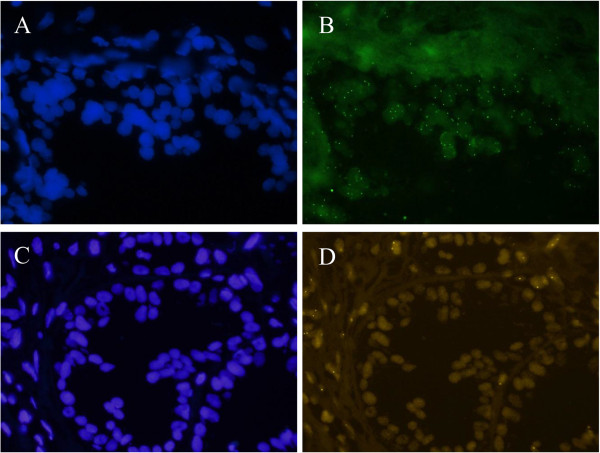
Images of abnormal FISH signals. A and B: The images of MYC SpectrumGreen copy number gain with DAPI staining (A) showing the nuclei morphology, and MYC staining (B) displaying gain of copy numbers. C and D: the images of PTEN loss with DAPI staining (C) of the tumour ROI, and PTEN FISH hybridisation showing deletion of PTEN in the prostate gland (D).